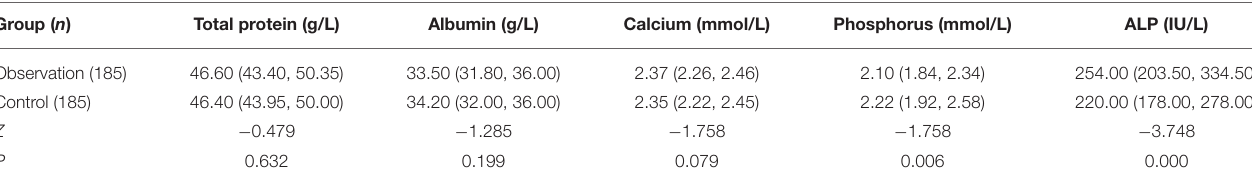
TABLE 7 | Comparison of serological examinations before discharge between the two groups of premature infants. Group ( n